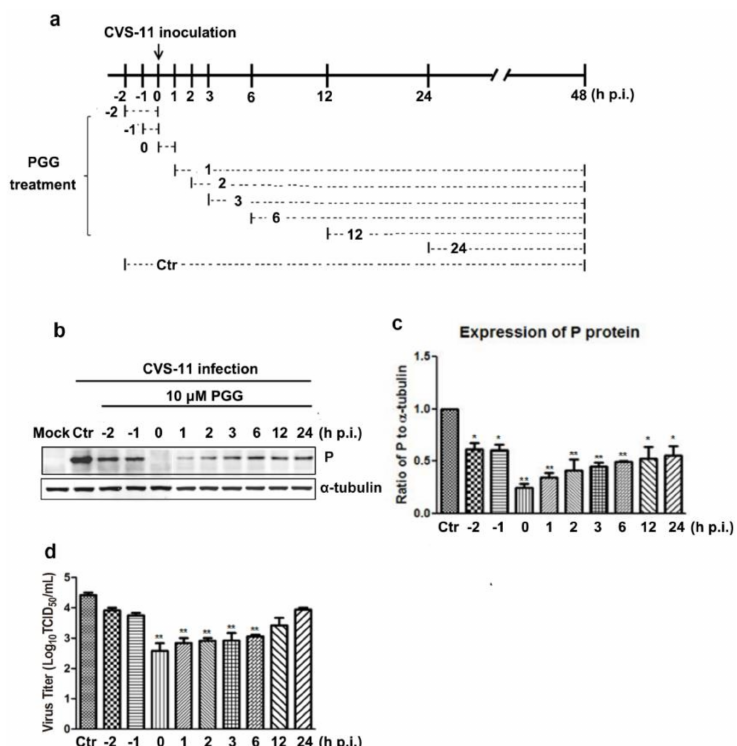
Figure 5. Time-of-addition assay. ( a ) Schematic representation of the experimental design. BHK-21 cells were treated with 10 µ M PGG at the indicated times. ( b ) The viral P protein expression level was analyzed by Western blotting at 48 h p.i. ( c ) The relative expression levels of viral P, normalizing to that of α -tubulin. ( d ) The virus titers of culture supernatants were determined by TCID 50 assay and plotted. Ctr is the abbreviation of control. (* p < 0.05; ** p <